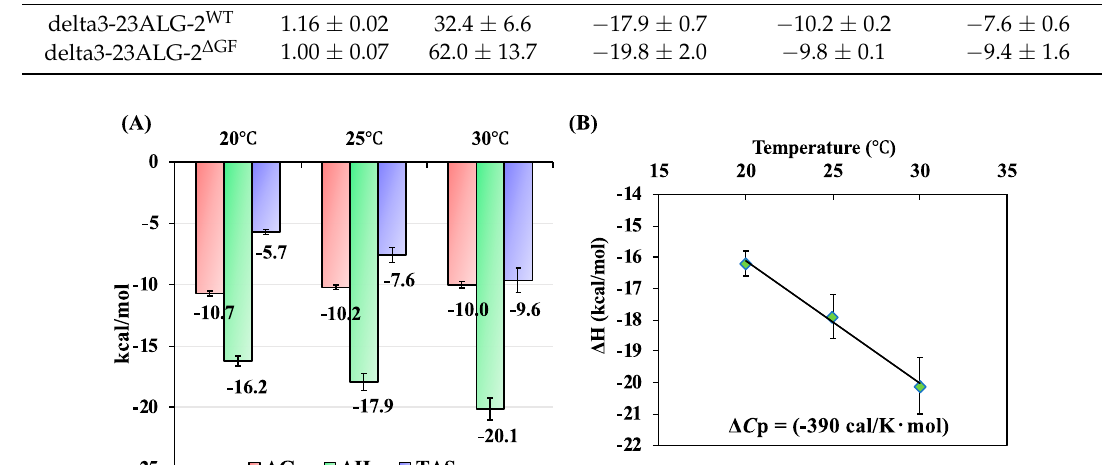
Figure 4. ( A ) The temperature dependence of the thermodynamic parameters in binding of SOUL WT to delta3-23ALG-2 WT . The Gibbs free energy change for binding ( ∆ G ) is represented in red, the enthalpy change for binding ( ∆ H ) is represented in green, and the entropy change for binding (T ∆ S ) is represented in purple. ITC measurements were performed in triplicate at each temperature. The observed ∆ H values were plotted versus temperature ( B ), and the ∆ Cp value was obtained from its slope.